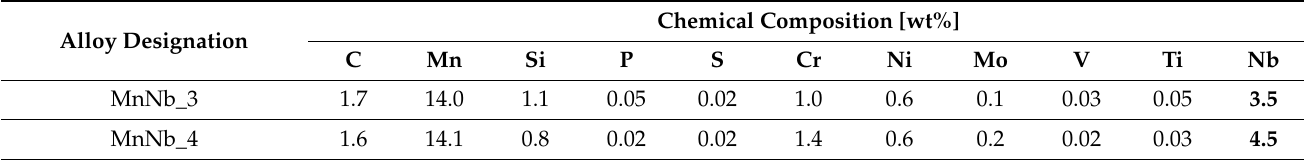
Table 1. Chemical composition of the tested high-manganese cast steel.